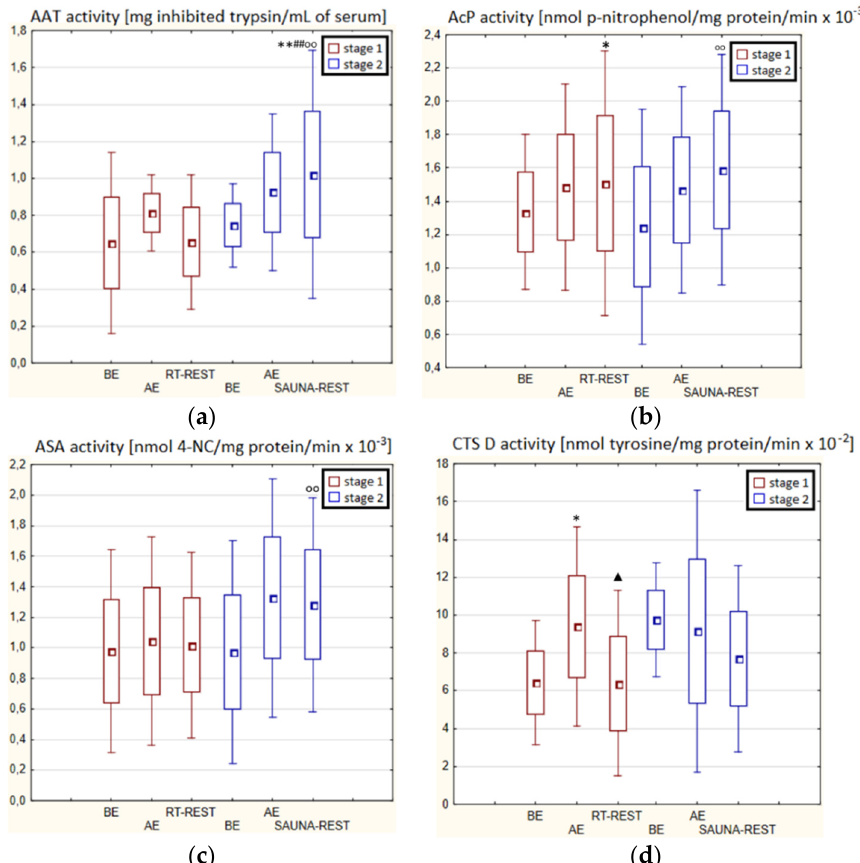
Figure 3. The activities of α 1-antytrypsin and lysosomal enzymes in blood serum of winter swim- mers ( n = 22) in Experiment II: ( a ) AAT activity; ( b ) AcP activity; ( c ) ASA activity; ( d ) CTS D activity. Data are presented as the mean values ± SD. AAT— α 1-antytrypsin, AcP—acid phosphatase, ASA—arylsulfa- tase, CTS D—cathepsin D, BE—before exercise, AF—after exercise, RT-REST—20-min recovery at room temperature, SAUNA-REST—rest combined with sauna bath, * p < 0.05 vs. BE, ** p < 0.001 vs. BE, ▲ p < 0.05 vs. AE, ## p < 0.001 vs. RT-REST, oo p < 0.001 vs. CWI-REST.